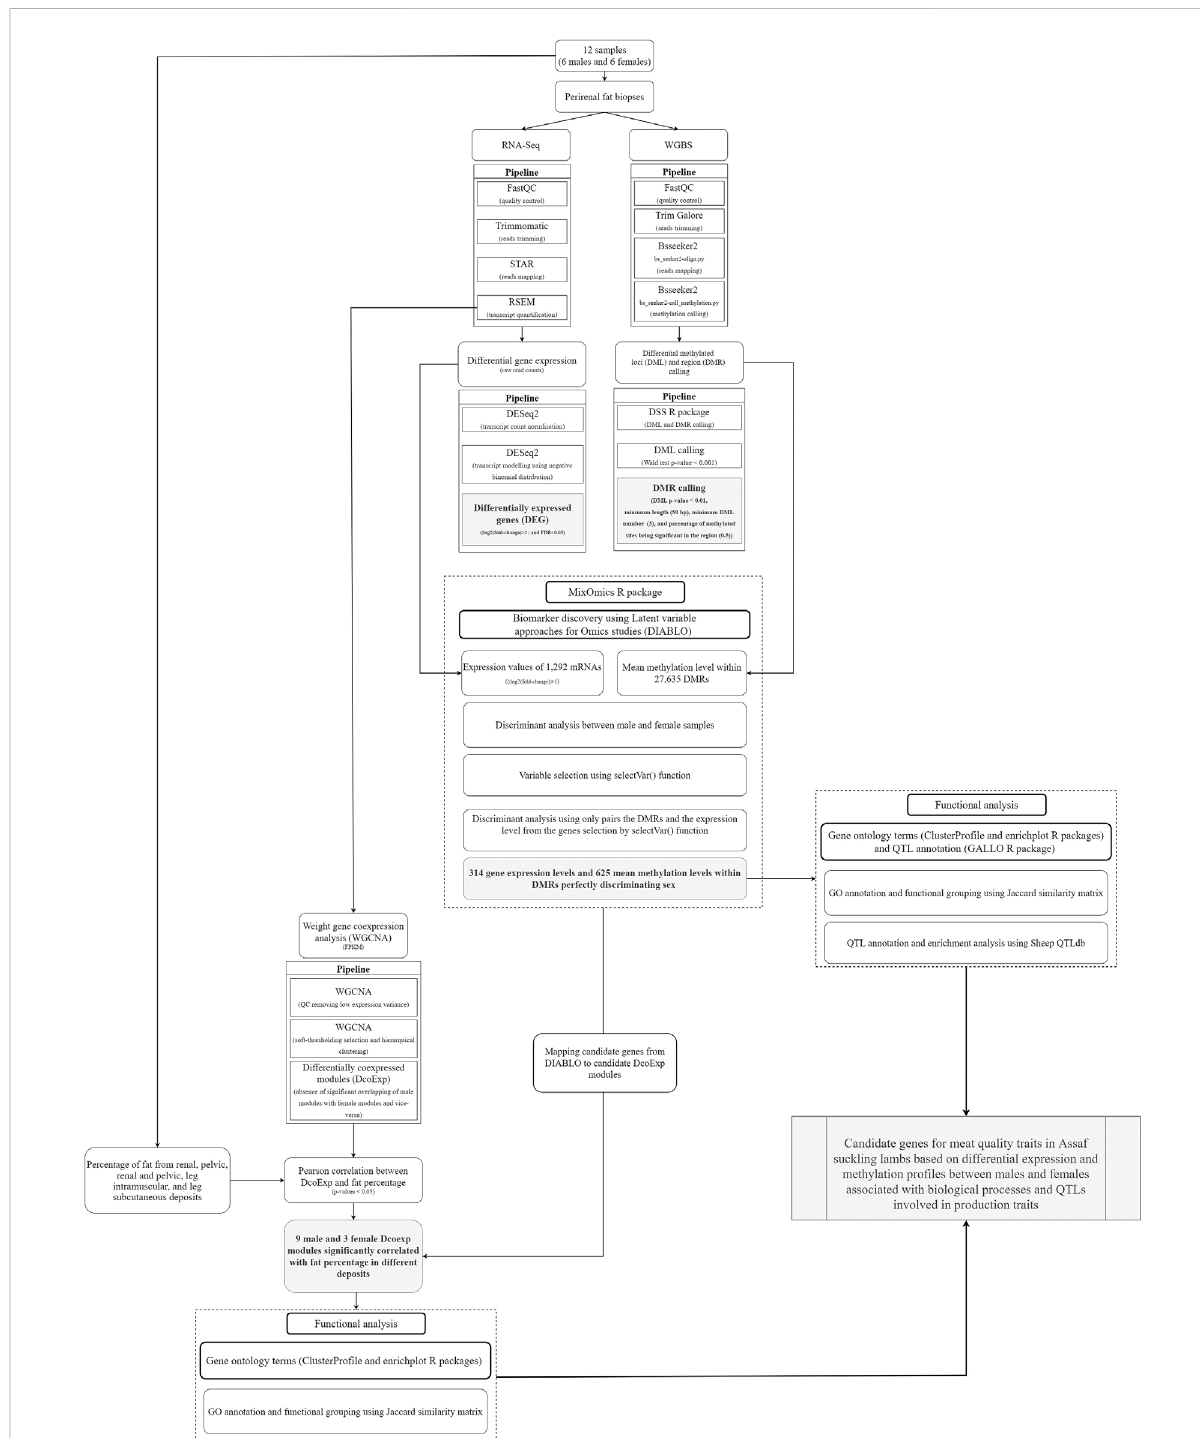
FIGURE 1 Flowchart summarizing the methods applied and the respective objectives reached in the current study. The grey boxes highlight the main results obtained in the methodological pipeline designed and applied in the present